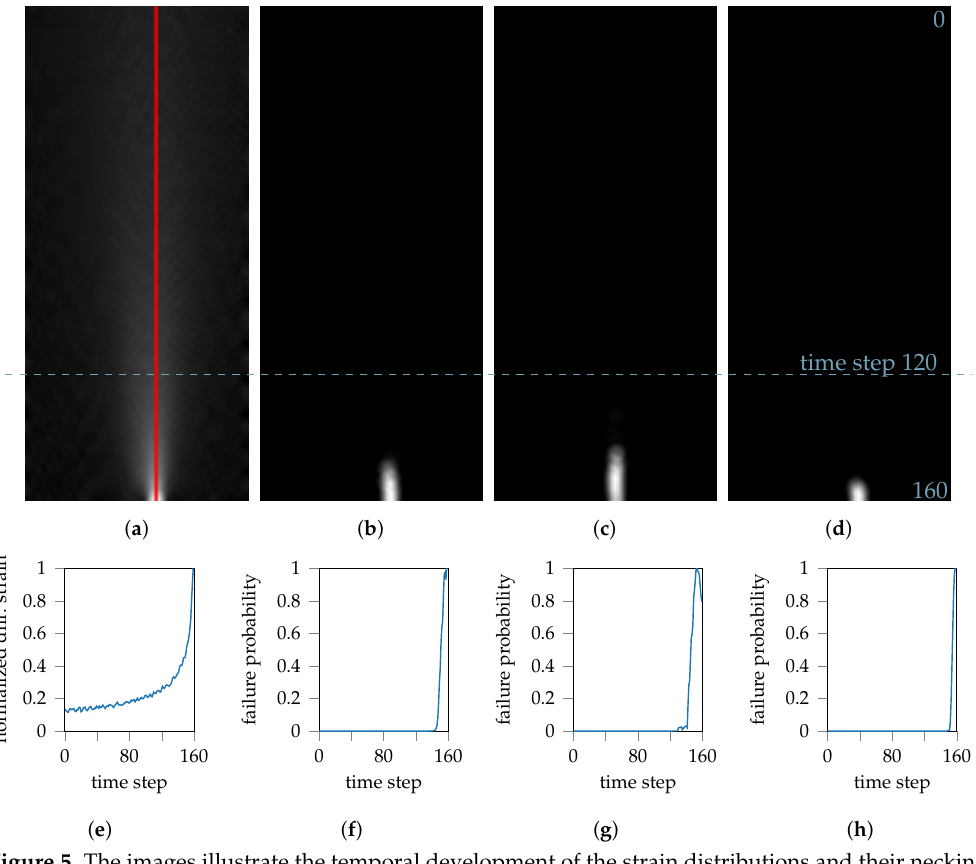
Figure 5. The images illustrate the temporal development of the strain distributions and their necking probabilities. The red line emphasizes the evaluation region of the line-profiles: ( a , e ) x-z representation of the difference images of DP800-S050-1 together with its incremental strain development as line-profile. ( b , f ) x-z representation of the segmented necking probability for DP800-S050-1 together with its line-profile through the maximum value. ( c , g ) and ( d , h ) x-z representation and line-profile for DP800-S050-2 and